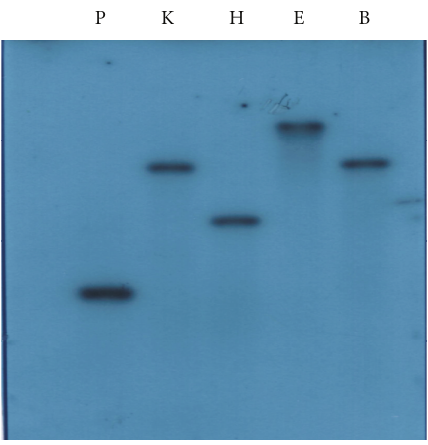
Figure 1: Southern blot analysis of CgPKAC using genomic DNA of wild-type C. gloeosporioides . Genomic DNA (8 μ g/Lane) of C. gloeosporioides wild-type wtrain was digested with Pst 1 (P), Kpn 1 (K), Hin dIII (H), Eco R1 (E) and Bam H1 (B). The blot was probed with a 695bp of CgPKAC fragment.